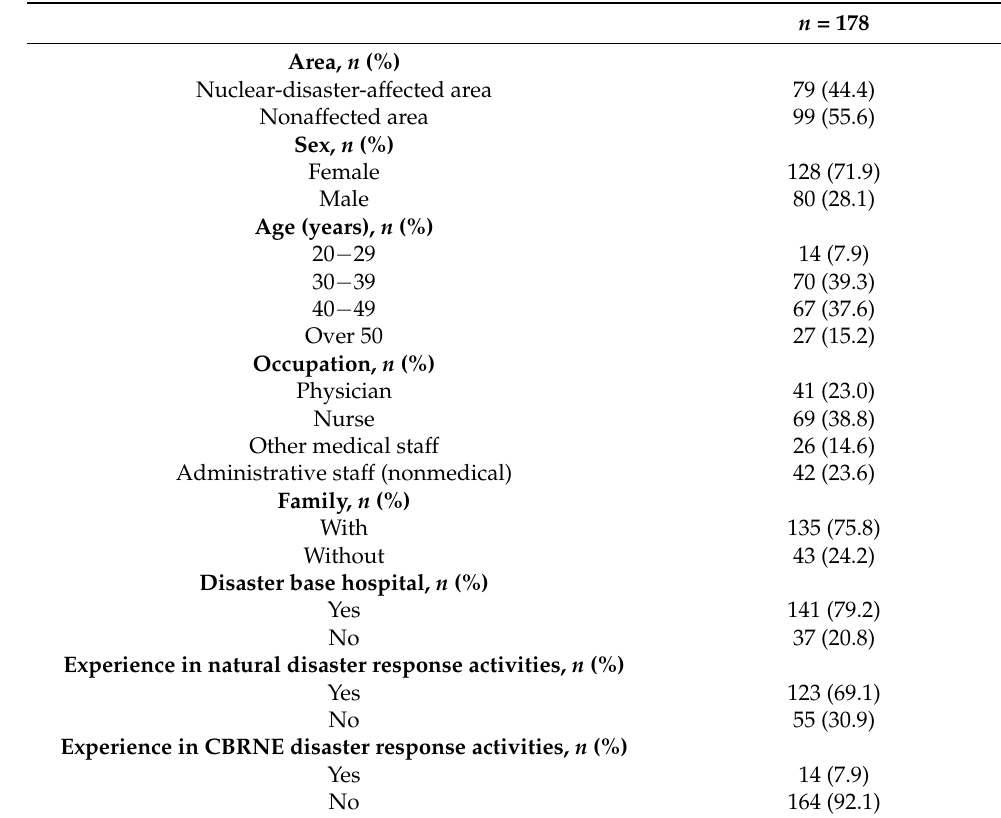
Table 1. Participant characteristics.